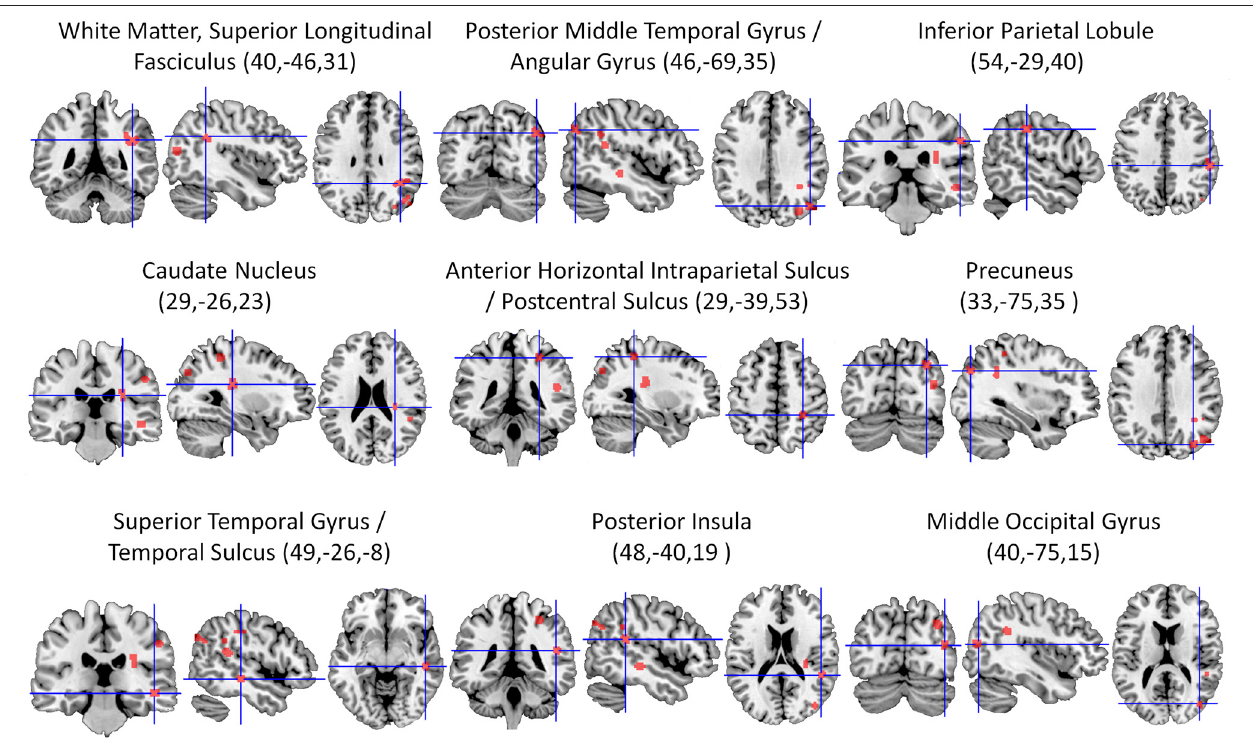
FIGURE 2 | Overview of all significant clusters (FDR, p < 0 . 05) derived from the ALE analysis of 20 lesion mapping studies (listed in Table 1), superimposed on a ch2better template using